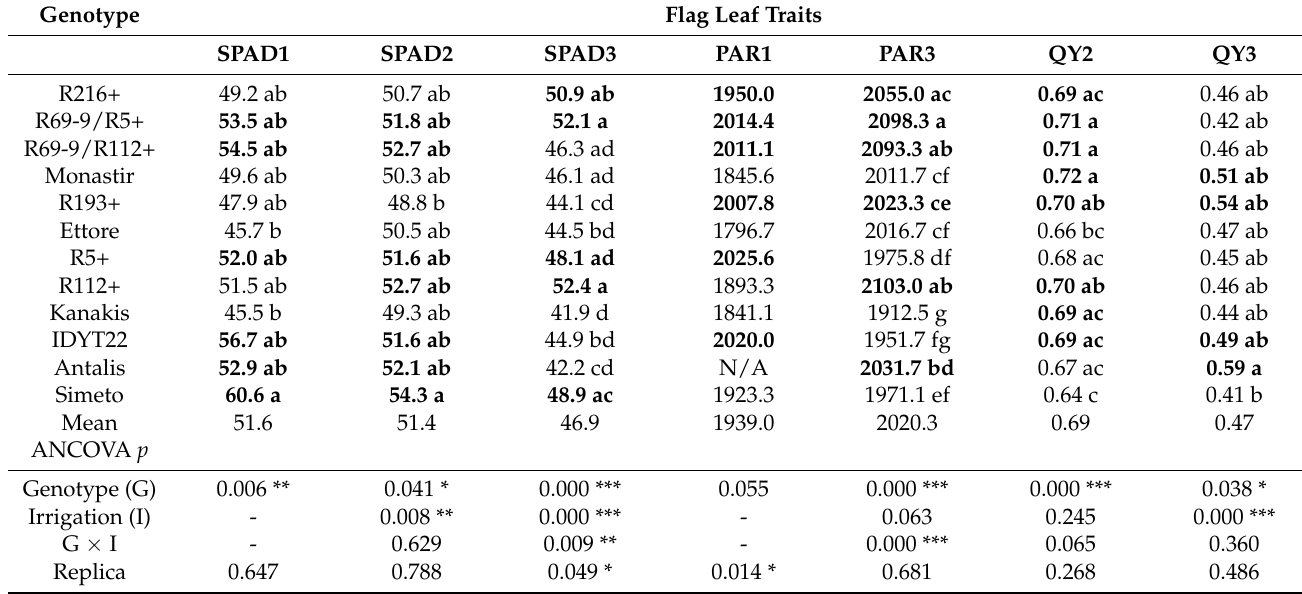
Table 5. Mean values and ANOVA of flag leaf traits recorded in 2020 for 7el 1 L + 7el 2 L and 7el 1 L + 7EL durum wheat RLs and control cultivars. Genotypes are ordered from the best to least productive according to GY in Table 4.